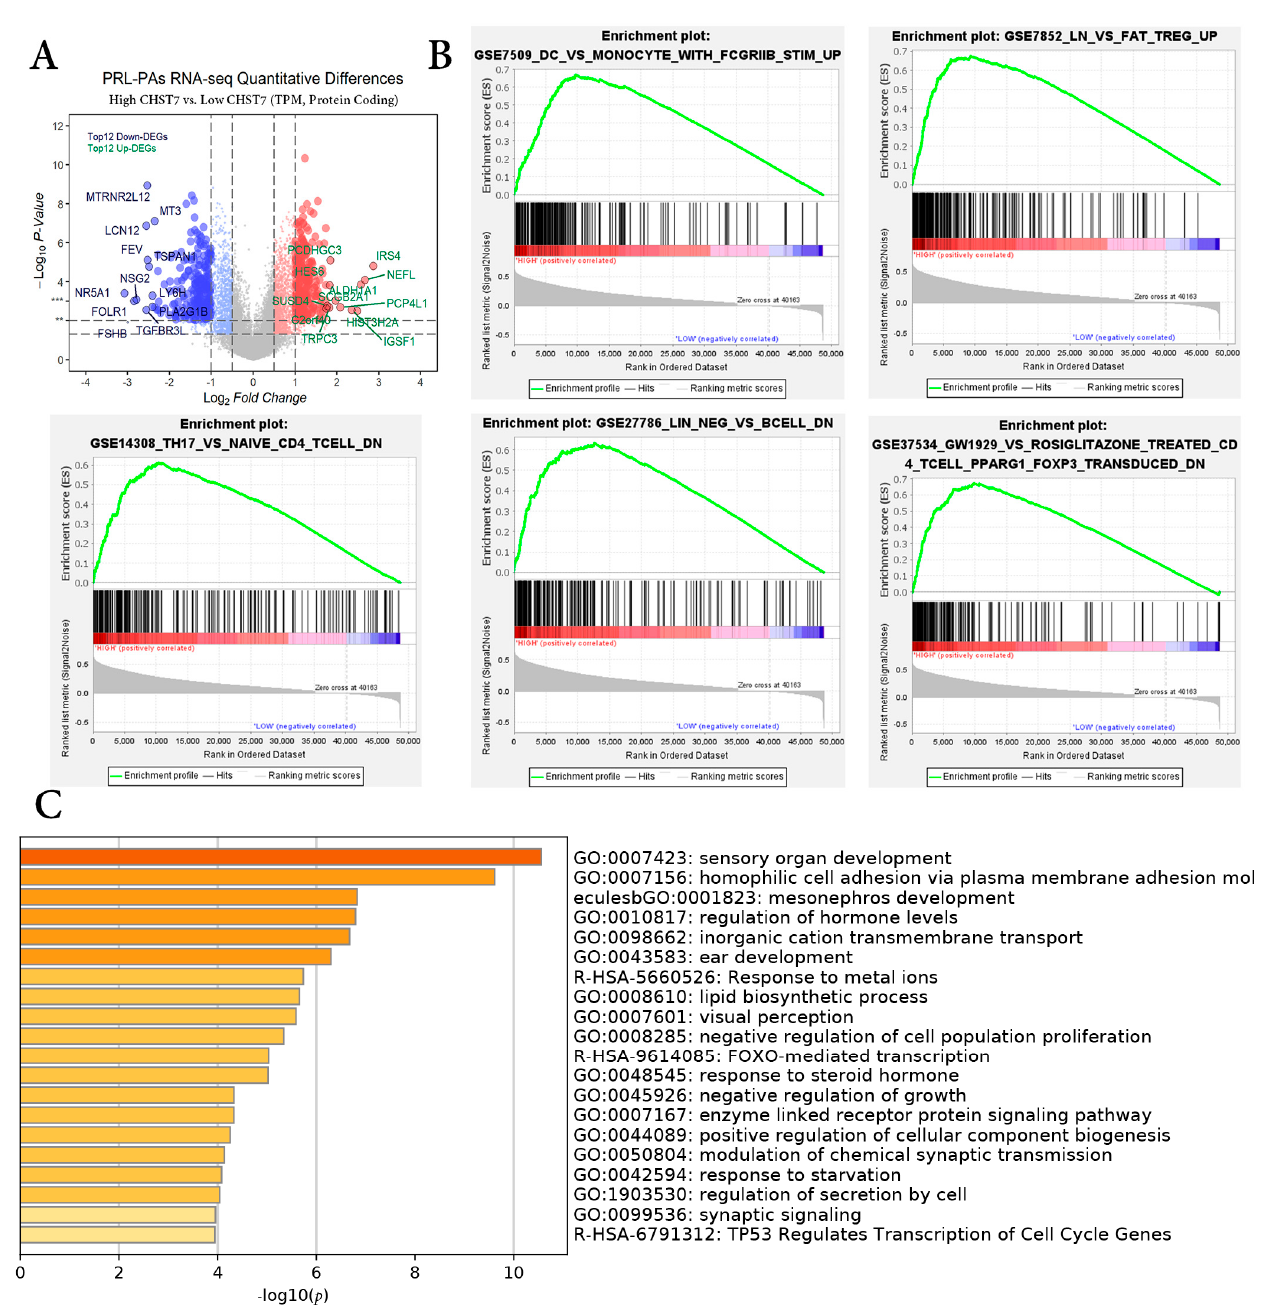
Figure 1. Differential gene enrichment analysis between different CHST7 groups. ( A ) Volcano plots showing the significantly differentially expressed genes. ( B ) GSEA employed to verify the signatures of the top 5 immunologic signature gene sets. ( C ) MetaScape enrichment analysis including pathways and GO terms.